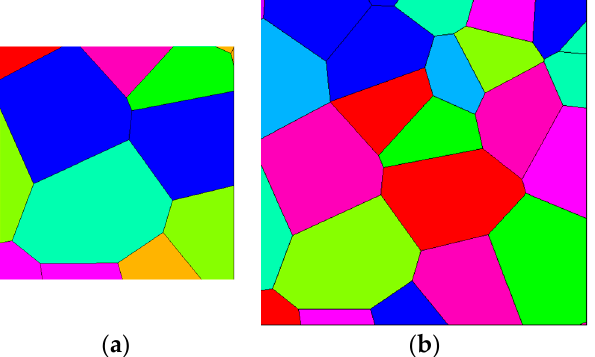
Figure 2. Exemplary regularized micro-structures of ( a ) 2 × 2 μ m and ( b ) 3 × 3 μ m SVEs, where grains are depicted with different colors.